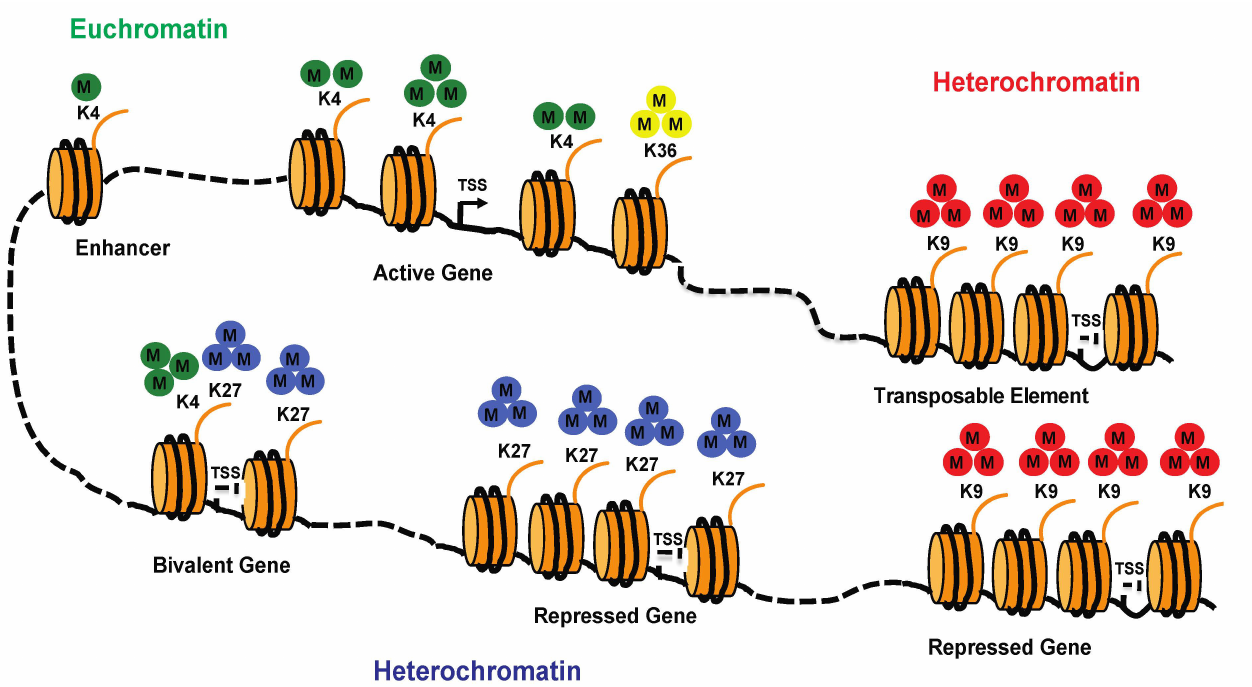
Figure 3. Modulation of chromatin organization and gene transcription by histone lysine methylation. A schematic representation of euchromatin and heterochromatin showing the main lysine methyl marks on histone H3 and their prevalent localization in the genome (euchromatin and heterochro- matin). Abbreviations: K, lysine; TSS, transcriptional start site; M, methyl